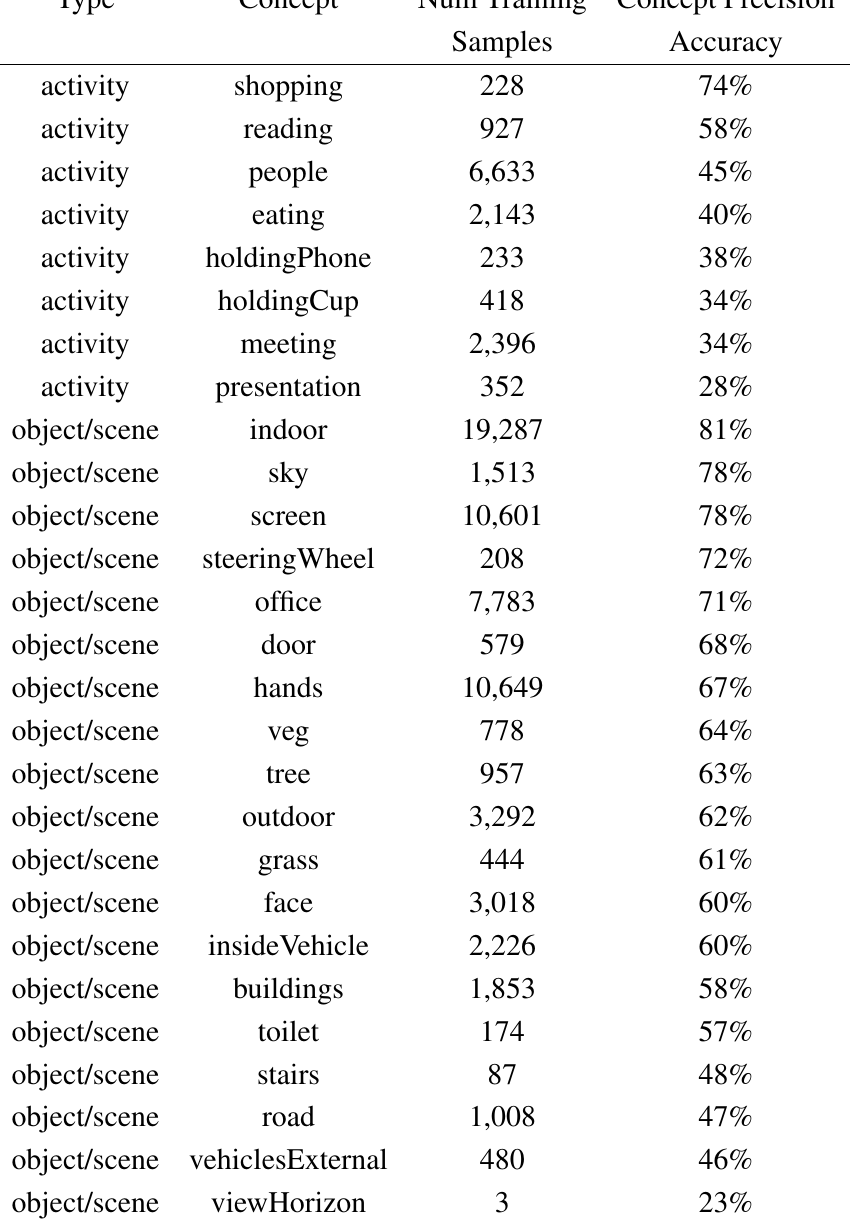
Table 3. Accuracy of activity recognition on lifelog data [31] (sorted by “Type” then by